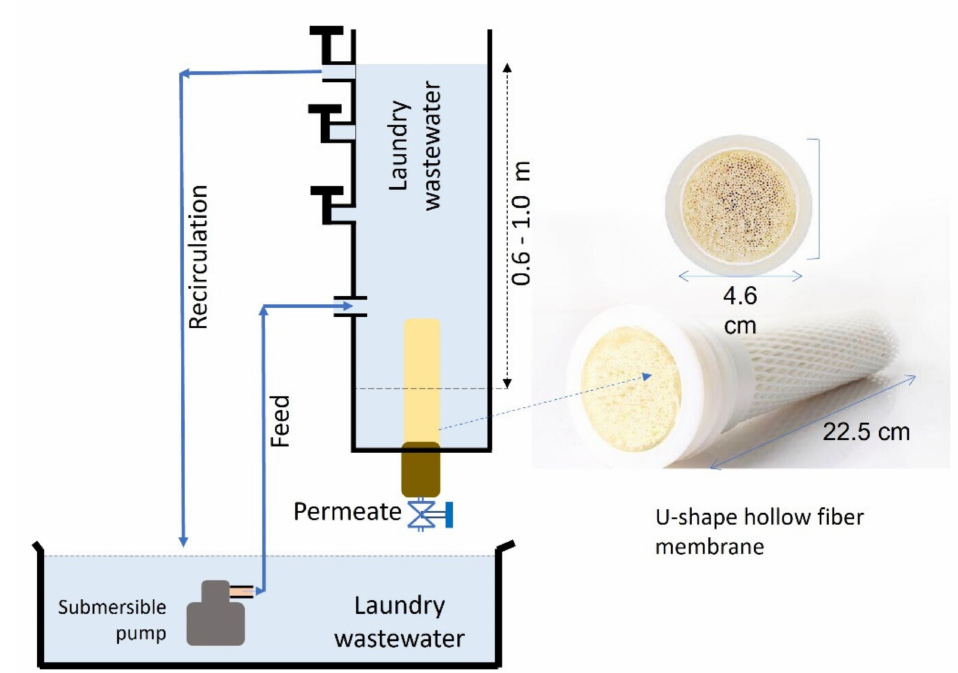
Figure 1. Illustration of gravity-driven, submerged membrane filtration set-up showing the feed overflow recirculation system that is used to maintain the feed level and the u-shaped hollow fiber membrane installed at the bottom of the filtration